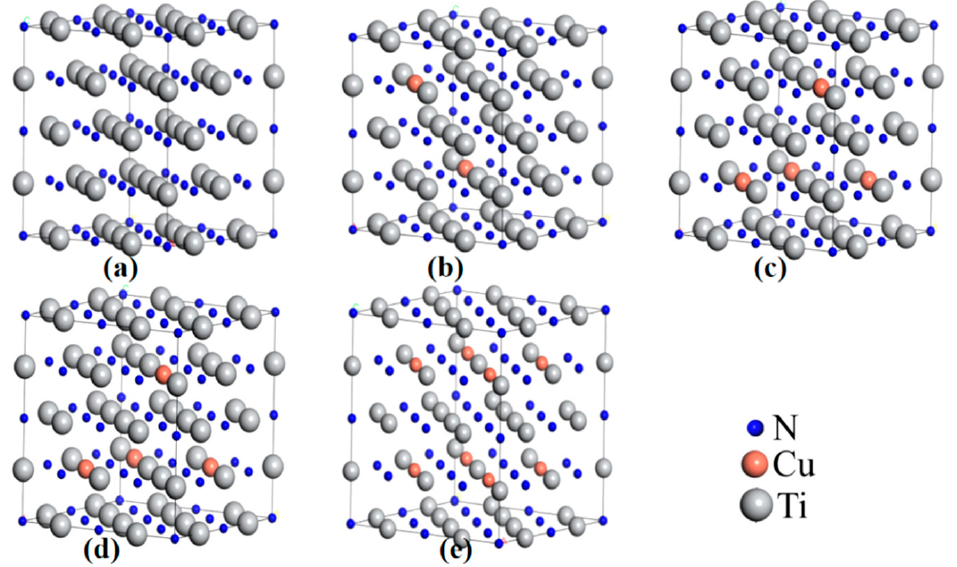
Figure 3. Supercell models of ( a ) Ti 32 N 32 ; ( b ) Ti 30 Cu 2 N 32 ; ( c ) Ti 28 Cu 4 N 32 ; ( d ) Ti 26 Cu 6 N 32 ; and ( e ) Ti 24 Cu 8 N 32 .